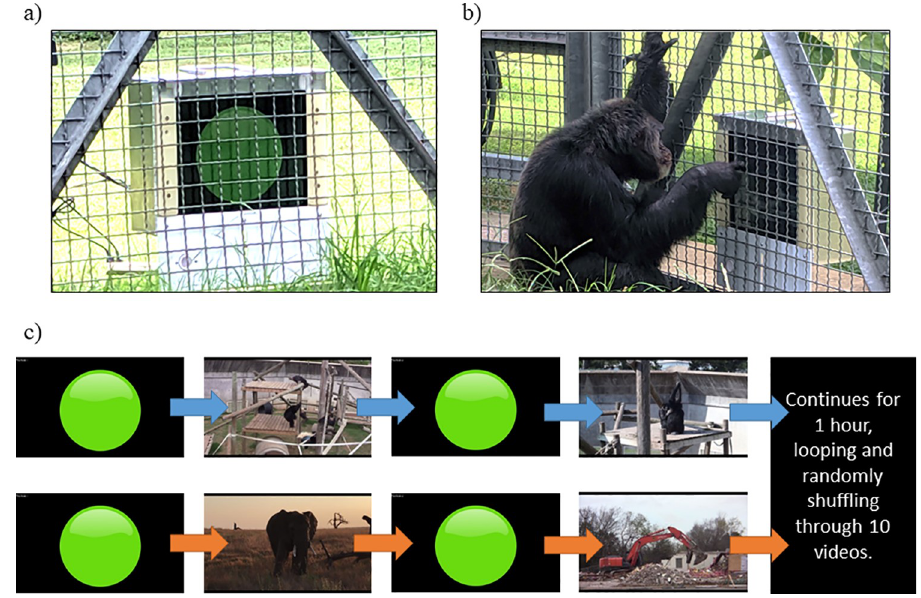
Fig 1. Touchscreen task set-up. a) The apparatus hanging on the wire mesh with the neutral start symbol on the touchscreen. b) A chimpanzee touching the neutral start stimulus to initiate video playback during a trial. c) Examples of how the touch screen program displays social (top) and control (bottom) videos. Note : All testing was done in the indoor dens; however, pictures A and B were taken outdoors in order to get a clear view of the screen in use.